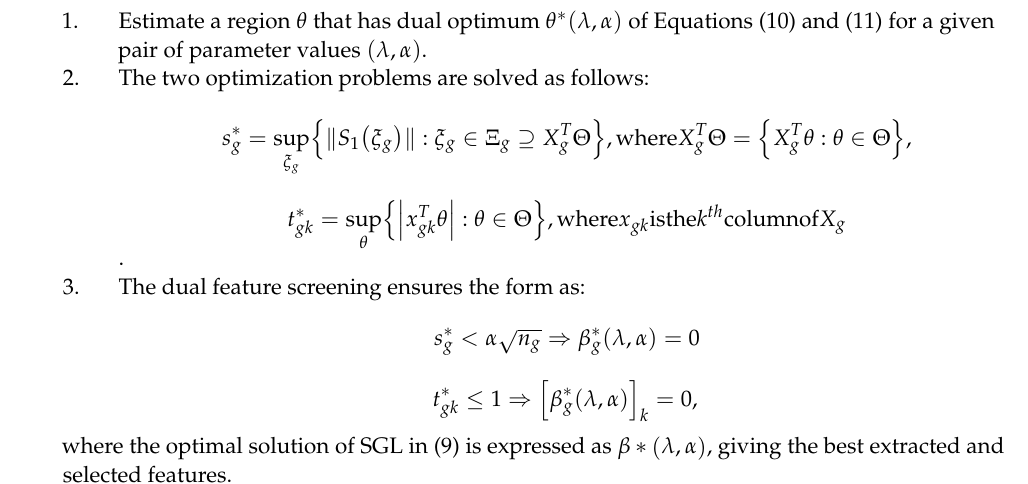
Algorithm 4: Procedure for developing dual-level feature extraction and